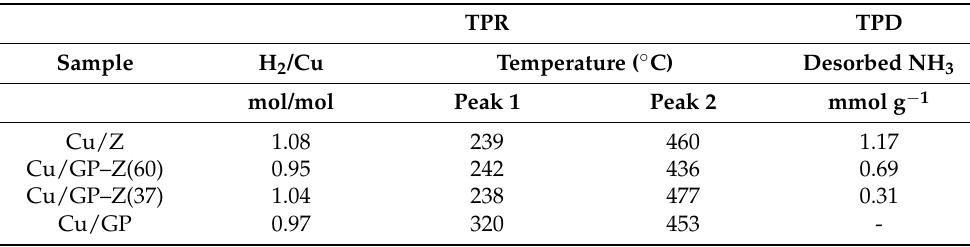
Table 2. Summary of the results for H 2 -TPR, and NH 3 -TPD (after NH 3 adsorption (@100 ◦ C) tests on Cu/GP and composite Cu/GP–Z(x) monoliths and pure Cu/Z